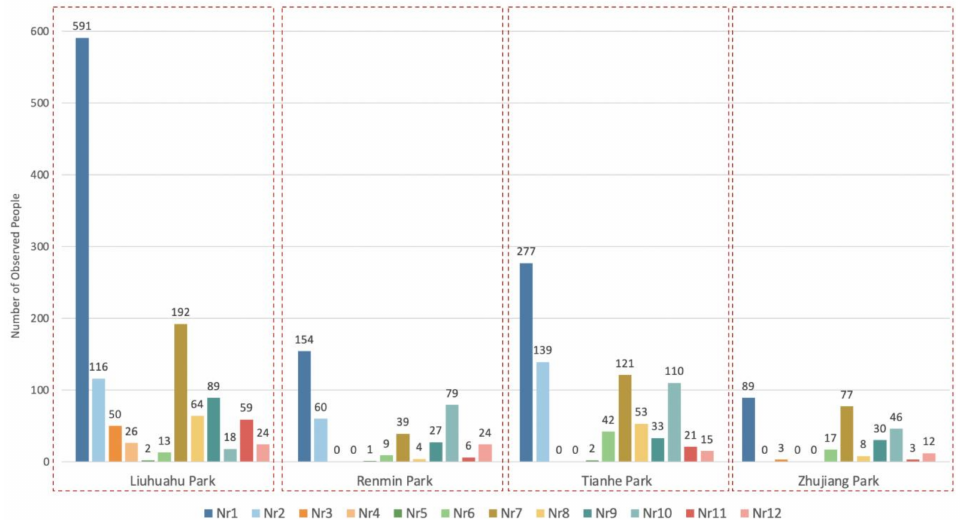
Figure 4. Number of observed people in various activity groups per hour (Nri) in the four parks.